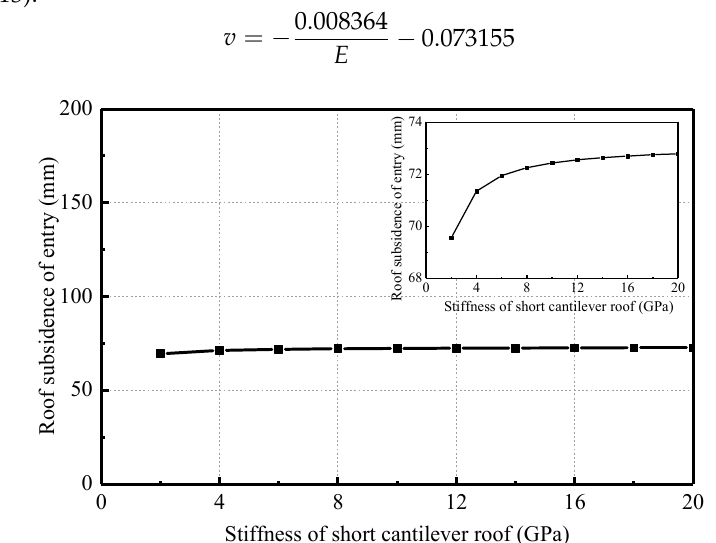
Figure 5. Relationship between roof subsidence and its stiffness.